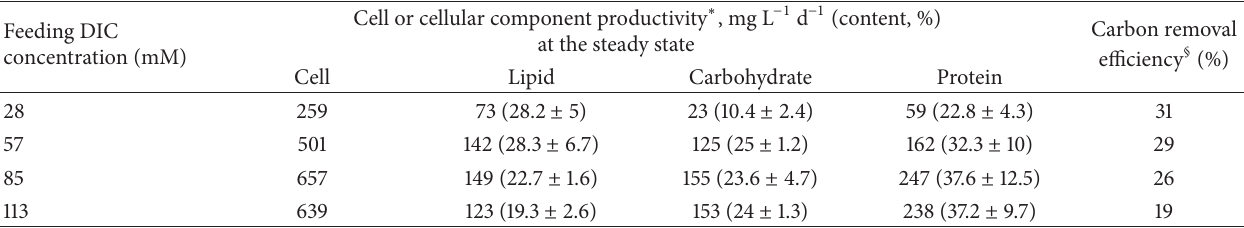
Table 1: Cellular data for TCL-1 in a continuous culture at various feeding DIC concentrations. Feeding DIC